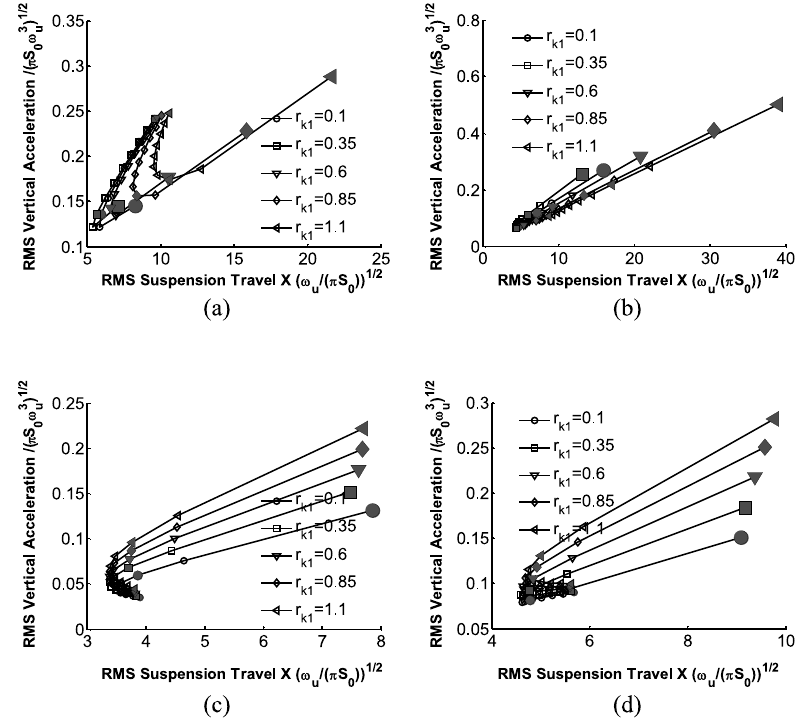
Fig. 8. Relationship between RMS acceleration and RMS suspension travel with layout s8 (effect of centering spring k 1 and damping): (a) Passive; (b) Groundhook; (c) Hybrid; (d)